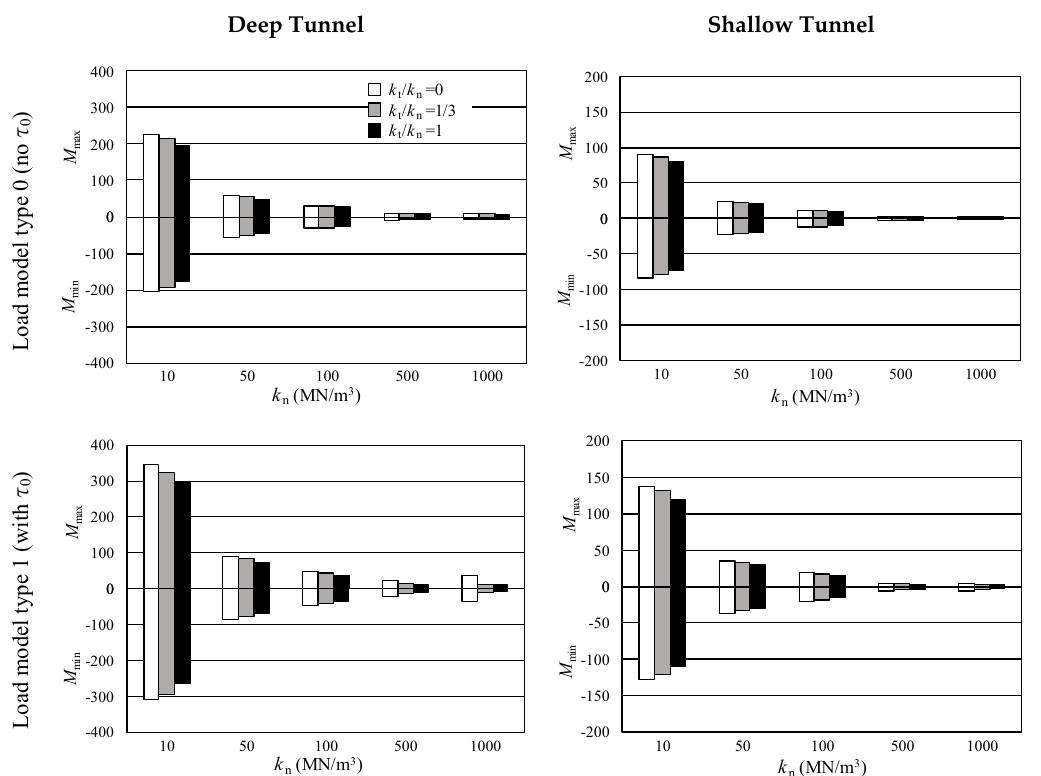
Figure 9. Maximum and minimum bending moment (kN-m/m).